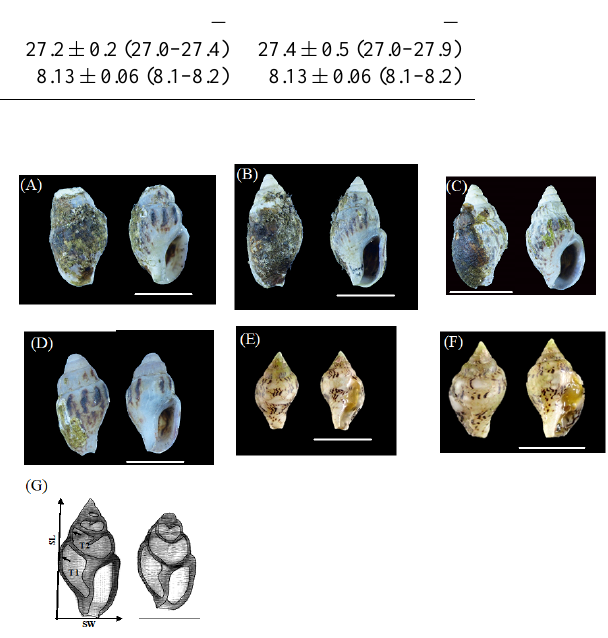
Figure 2. Shell morphology and X-ray photos of Anachis misera around the vent off Kueishan Islet and Euplica sp. from non-vent control sites of Da-xi and Geng-fang. (a) A. misera from the east site; (b) A. misera from the south site; (c) A. misera from the south- west site; (d) A. misera from the northwest site; (e) Euplica sp. from Da-xi; (f) Euplica sp. from Geng-fang; (g) X-ray photos of A. mis- era from the south site(left) and the northwest site (right). Scale bar: 5mm; SL: shell length; SW: shell width; T1: thickness of body whorl; T2: thickness of penultimate